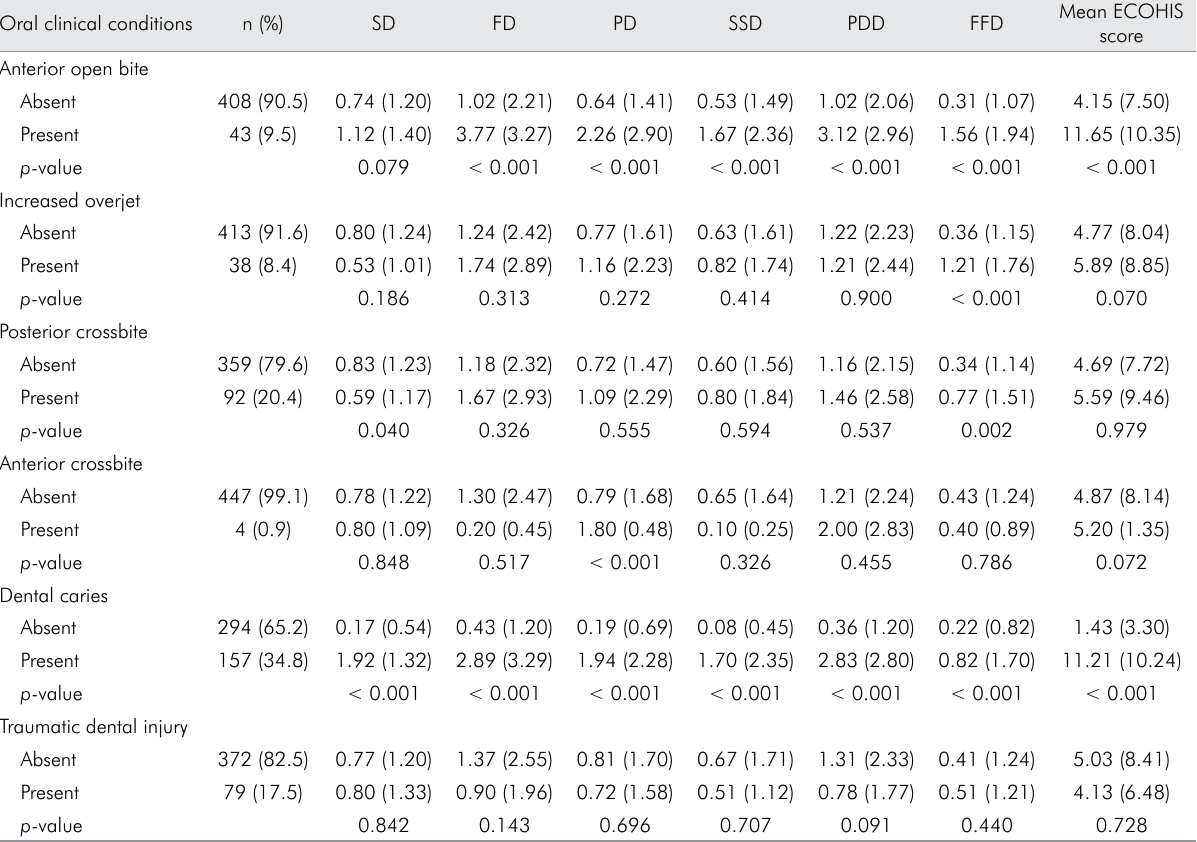
Table 1. Mean scores on ECOHIS domains according to different oral clinical conditions. Oral clinical